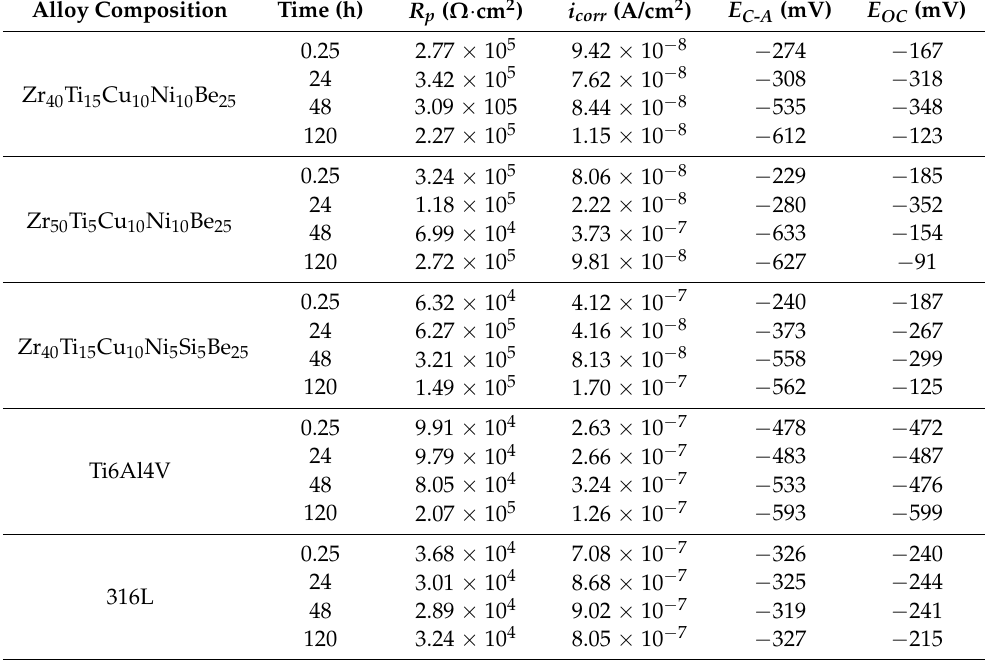
Table 1. Polarization resistance ( R p ), corrosion current density ( i corr ), cathodic to anodic tran- sition potential ( E C-A ), and open circuit potential ( E OC ) for the produced Zr 40 Ti 15 Cu 10 Ni 10 Be 25 , Zr 50 Ti 5 Cu 10 Ni 10 Be 25 , Zr 40 Ti 15 Cu 10 Ni 5 Si 5 Be 25 alloys, reference 316L steel, and Ti6Al4V alloy recorded after different times (0.25, 24, 48, and 120 h) of exposition in SBF. Alloy